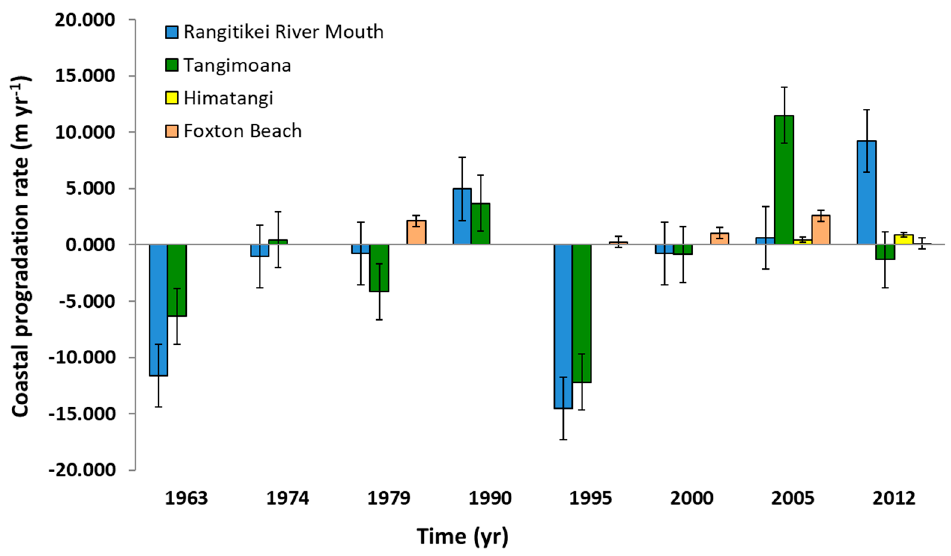
Figure 4. Coastal movement rates at the Rangitikei River Mouth, Tangimoana, Himatangi and Foxton Beach against date of imagery. Note that missing bars do not imply values of zero.